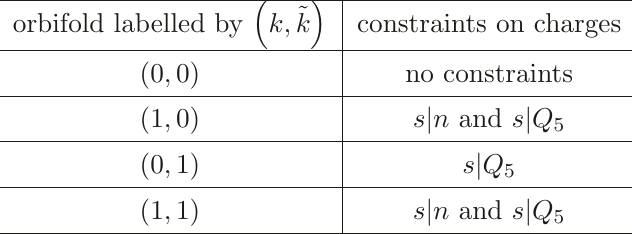
Table 1 . Arithmetic conditions on charges arising from flux quantization